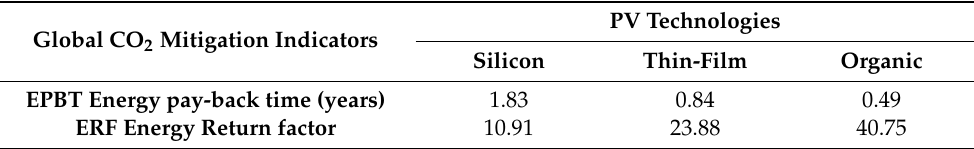
Table 6. Mitigation potential of three types of solar cells for a 5.4 kWp SHS for Las Calabazas,